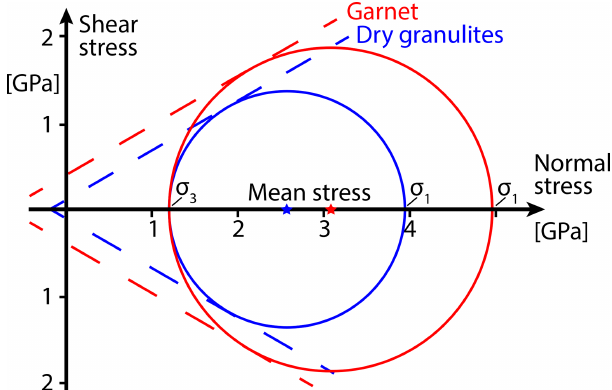
Figure 7. Mohr circles for the fracturing of dry granulites and garnet at a 1.2GPa lithostatic